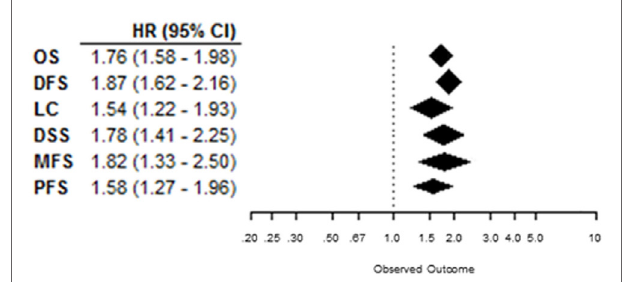
FiGURe 2 | Summary plot of the overall HRs from each endpoint analyzed . Symbols represent the HR with 95%CI, and dashed line indicates no association between CAIX expression and